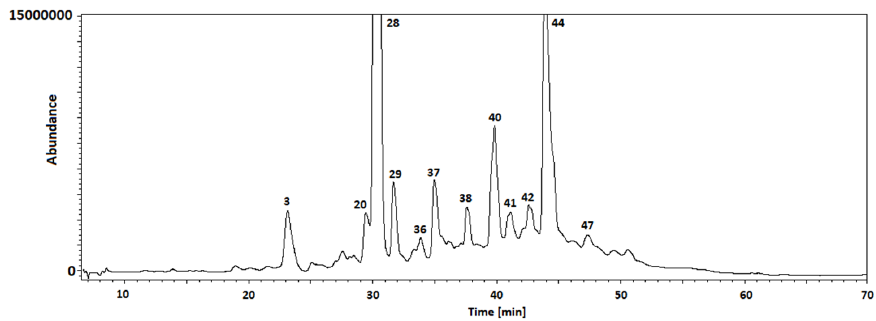
Figure 3. TIC chromatogram of C. hissaricus extract.